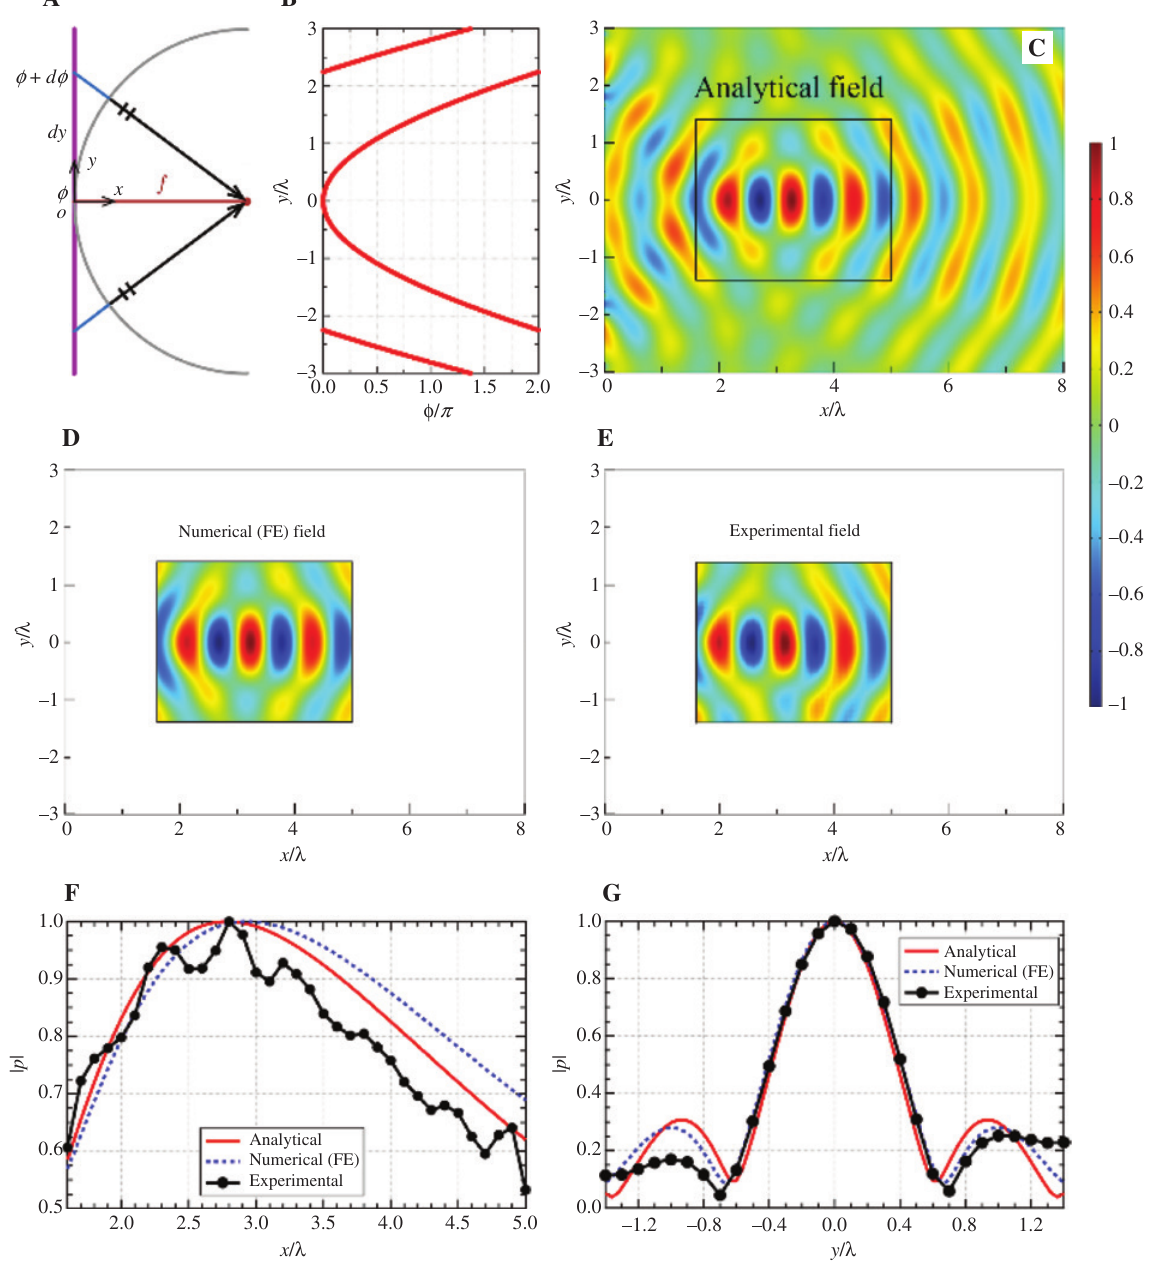
Figure 2: A planar and ultrathin lens for acoustic focusing. (A) Schematic for deriving acoustic focusing by a planar and ultrathin lens. (B) The desired phase profile on the metasurfaces. (C) The pressure-field distribution predicted by Green’s function theory with the black box indicating the region within which the measurement is performed. (D) The numerical simulation of metasurface composed by labyrinthine units and (E) the experimental results of the pressure- field distribution in the scanned region. (F, G) Acoustic pressure amplitude profiles (F) along the acoustic axis and (G) the radial direction in the focal plane (reprinted from Ref. black box) and the numerical and experimental results of phase at y , to compose the acoustic metasurface capable of the pressure distribution in the measured region. The good manipulating the reflected wavefront as desired. agreement between these results clearly prove the capa- Figure 2C–E plot, respectively, the spatial distribution bility of the designed acoustic metasurface to focus the of acoustic pressure predicted theoretically by Green’s func- incident acoustic energy into the predesigned spot despite tion theory (with the measured region being marked by the